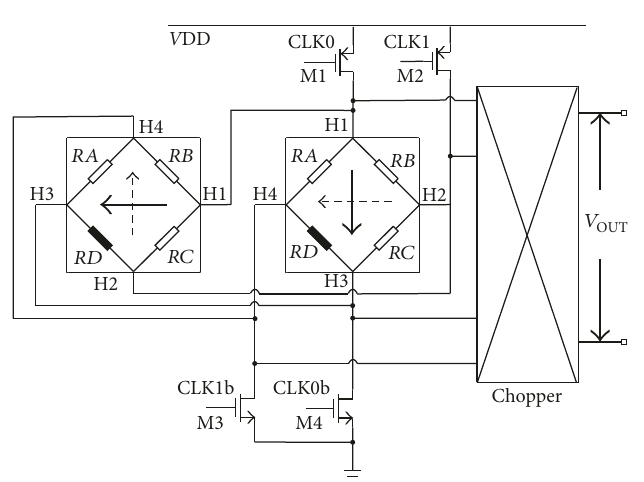
Figure 5: Orthogonal coupled spinning current